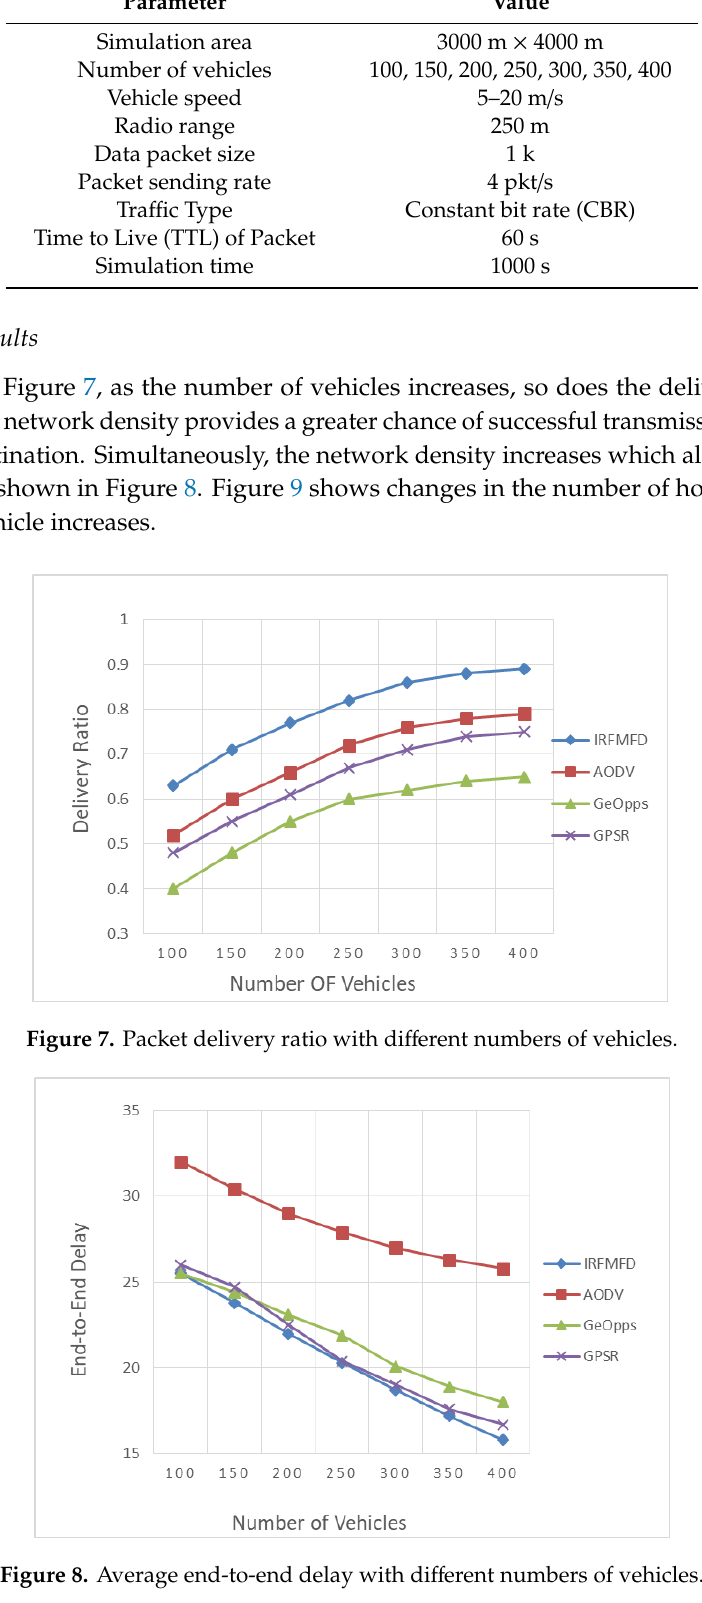
Table 5. Simulation parameter.